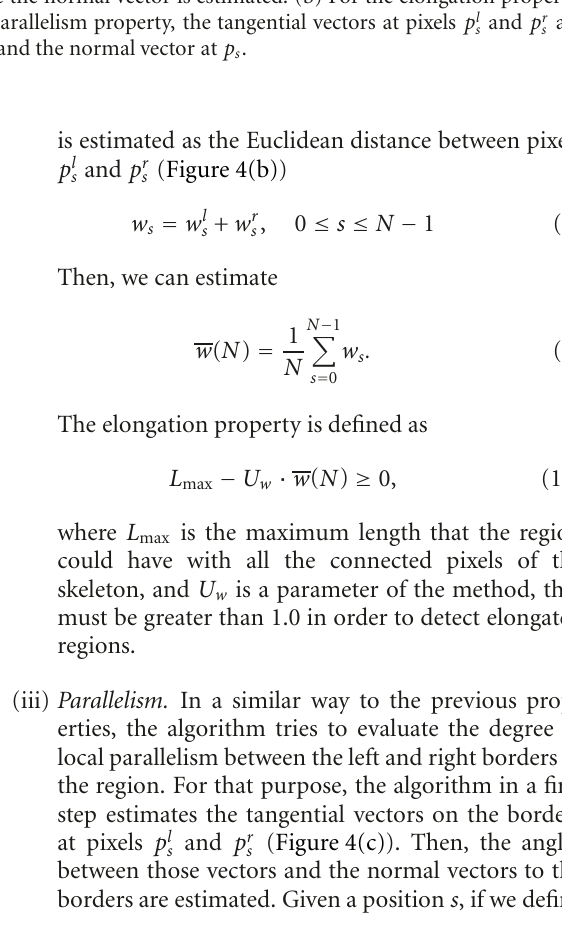
and p r pixels, respectively. The widths w l s s